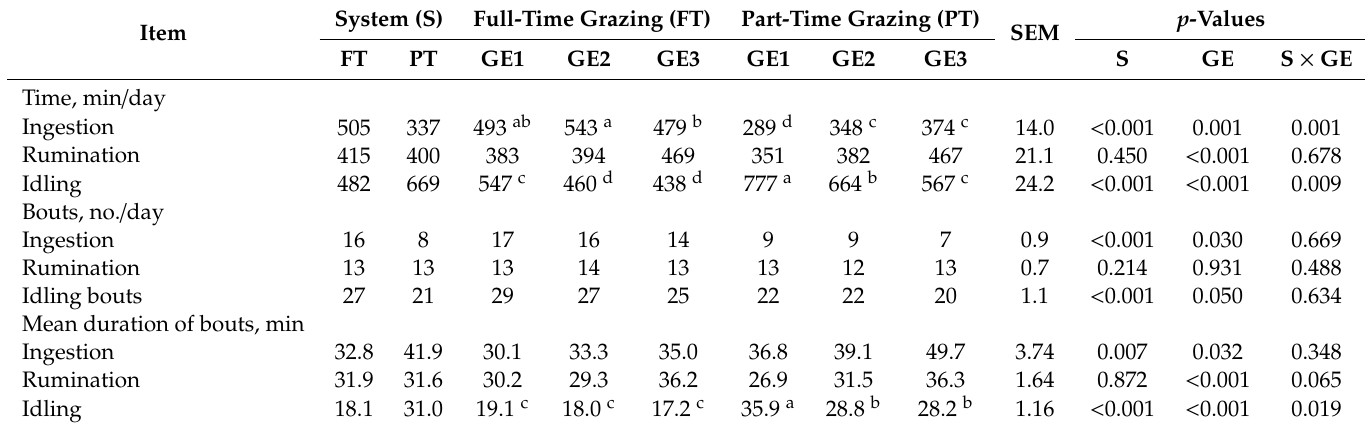
Table 3. Least square means of variables describing feeding and rumination behavior of cows in the two pasture management systems and the three GEs. System (S) Item